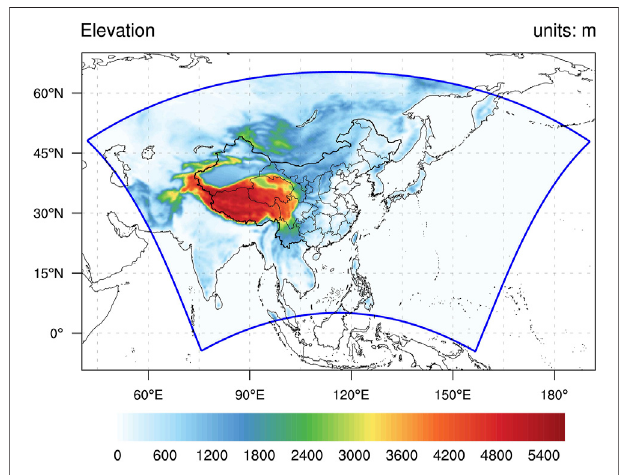
FIGURE 2 | The simulation domain and elevations (units: m) of the model. The blue lines indicate the boundary of the simulation domain.